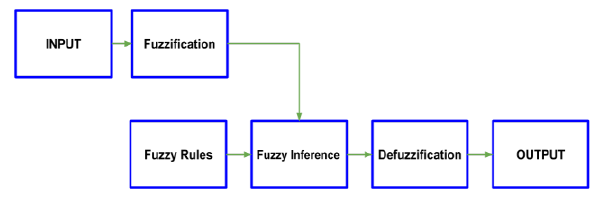
Figure 3. Fuzzy Logic System adopted from (L.-X. Wang 1999)